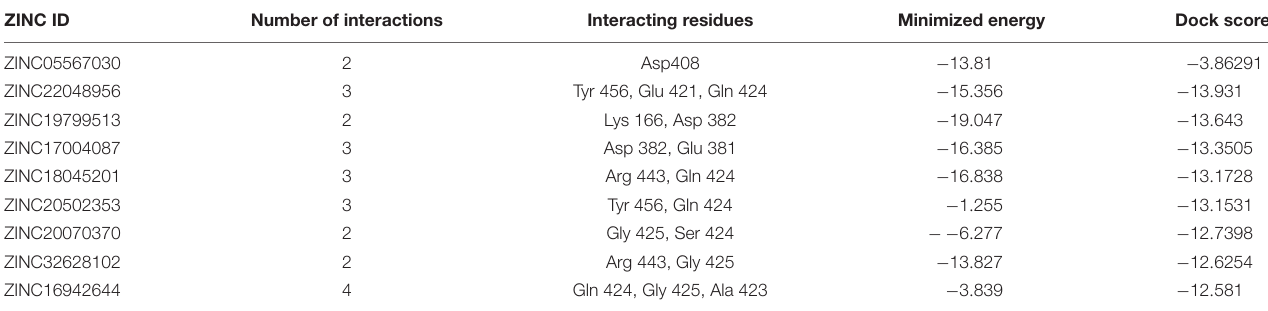
TABLE 9 | Penicillin-binding protein 2A and its interaction profile with docked compounds, their ZINC ID, minimized energy, number of interactions, dock score, and interactive